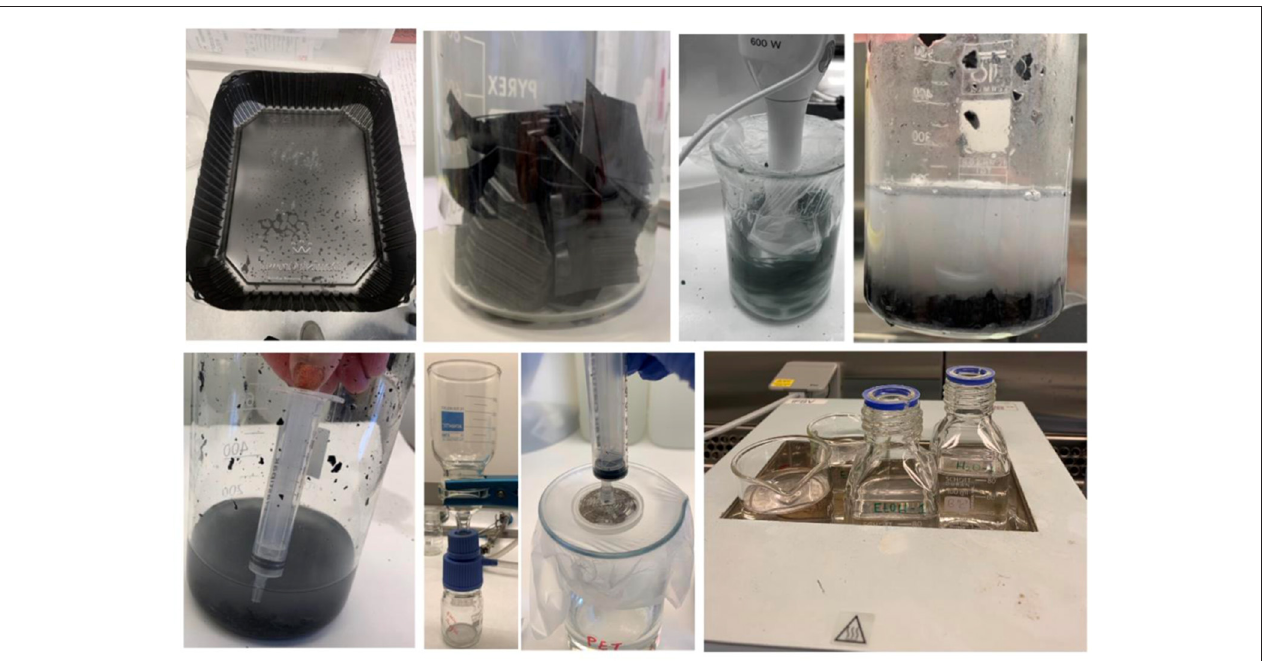
FIGURE 2 | Preparation of PET particles for the main study. Top from left to right: the PET food container was first sterilized using 96% ethanol. The plastic was then cut into 5cm long strips. The pieces were mixed with ethanol for 10min at room temperature. The plastic-ethanol suspension was left to sediment for 5min and 400ml of the suspension extracted using a plastic syringe and filtered through a paper filter using a vacuum pump. The filtrate was further filtered through a 0.45 disk filter. The final suspension was left to evaporate at 65 ◦ C in a heating